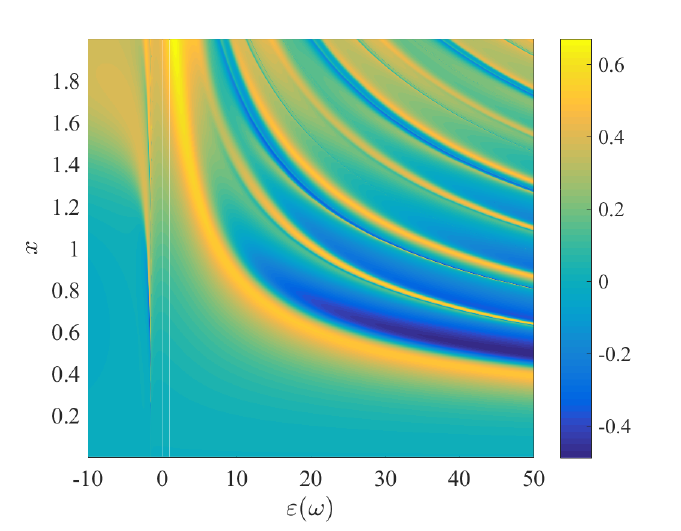
Figure 8. The normalized asymmetry factor, g , as a function of sphere’s permittivity and the size Q sca parameter. Note the existence of peaks and valleys, which is a direct indication of the interference of resonant multipoles in the studied